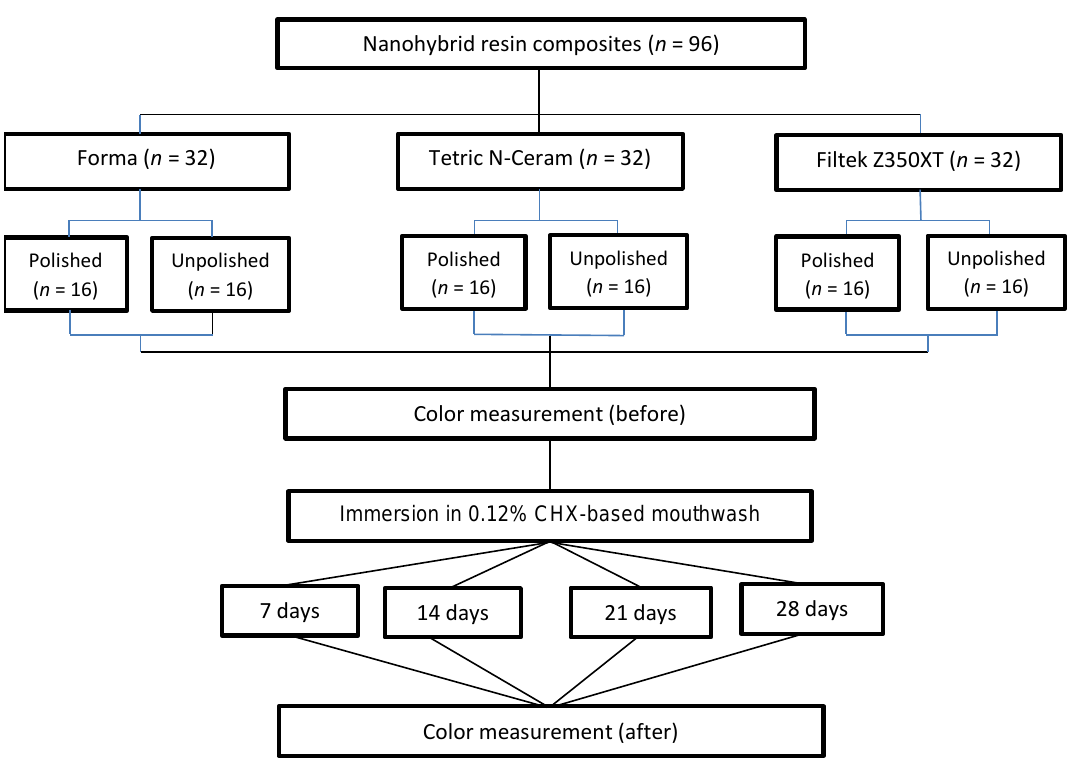
Figure 1. Random distribution of groups according to type of resin composite, 0.12% chlorhexidine immersion and with/without polishing.